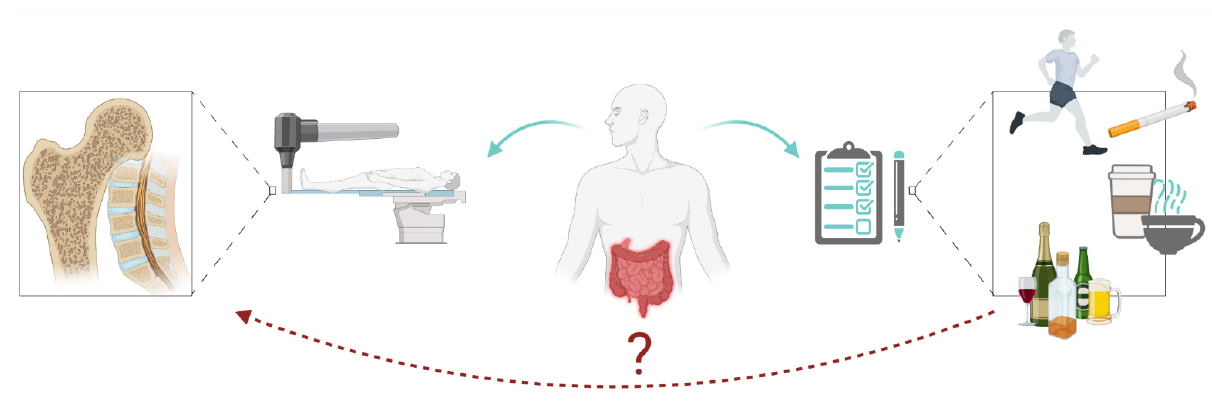
Figure 2. The graphical summary of the methodology.